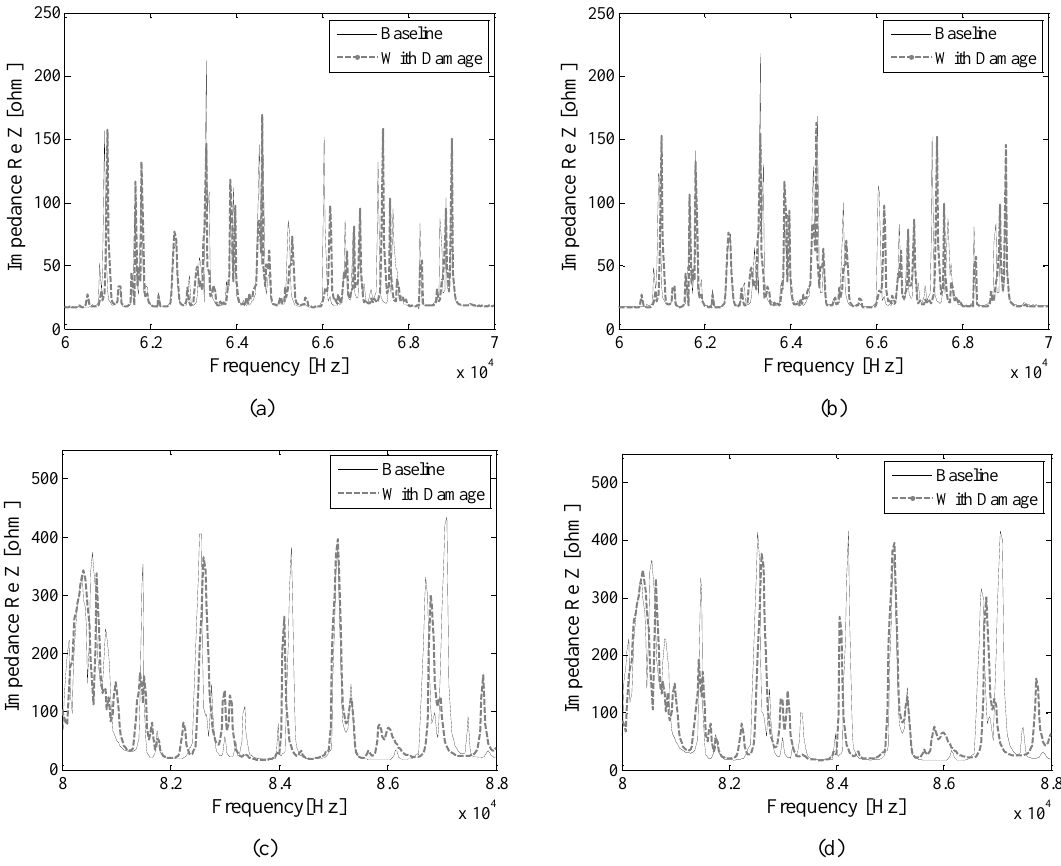
Fig. 3. Impedance measurement: (a) Square PZT patch on the plate; (b) Circular PZT patch on the plate; (c) Square PZT patch on the beam; (d) Circular PZT patch on the beam.